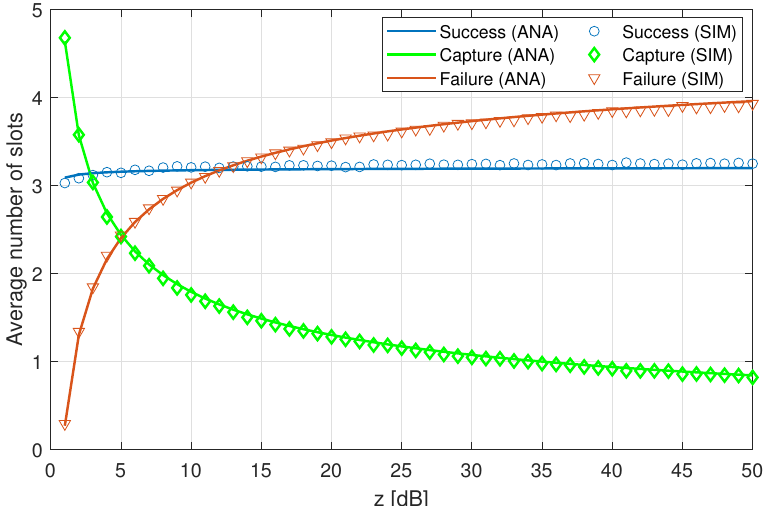
Figure 12. Average number of slots with with successful single transmission, captured packet, and failure, in terms of the capture threshold, within a RAW slot of duration T S = 20ms and N = 10 assigned